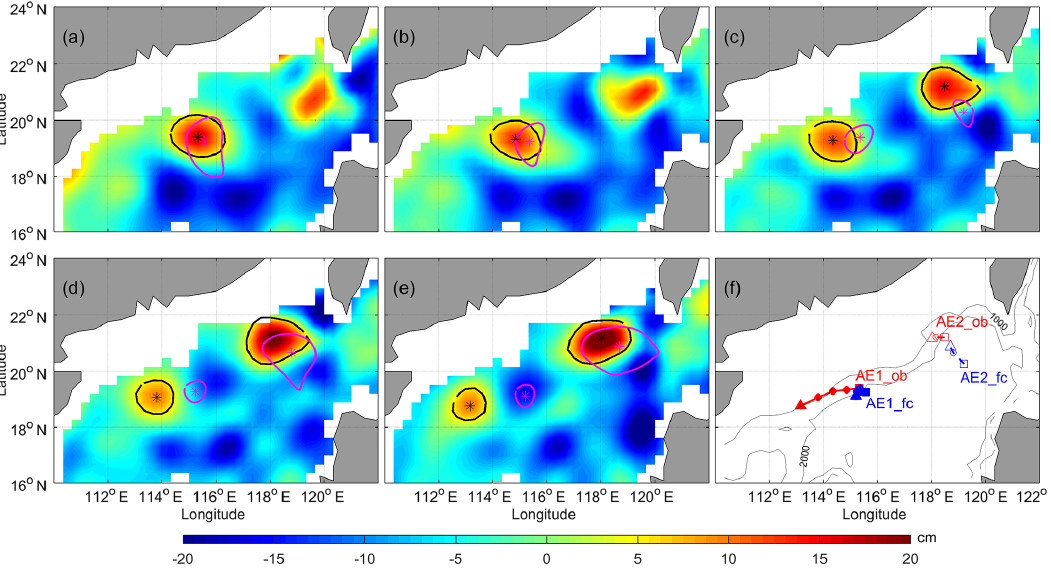
Figure 11. Same as Fig. 8, but for Exp4 where the red (blue) dotted line in (f) is the observation (forecast) moving path of AE1 and AE2. The solid (dashed) red lines and solid (hollow) circle are derived from observation SLA for AE1 (AE2); the solid (dashed) blue lines and solid (hollow) circle are derived from forecast SLA during the 21 January to the 20 February 2004.